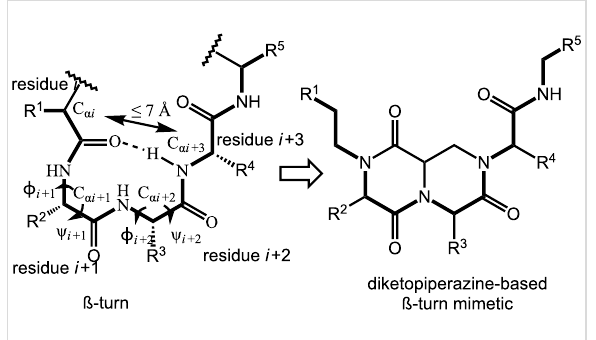
Figure 2: Spatial similarities between a natural β -turn conformation and a DKP based β -turn mimetic [158].